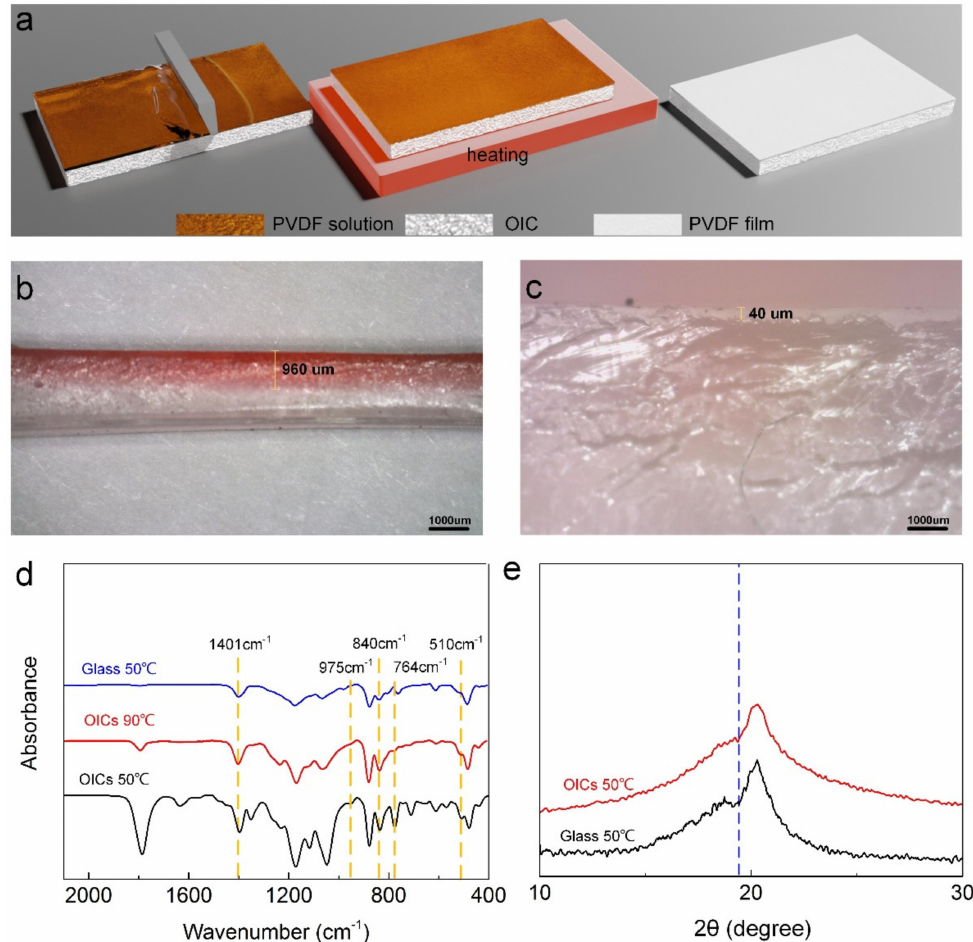
Figure 4. PVDF polarization detection. ( a ) Self-powered OIC preparation process, ( b ) penetration of DMF on OIC, and ( c ) the thickness of PVDF. ( d ) FTIR spectra of self-powered OICs on different substrates, and ( e ) XRD patterns of PVDF on glass and OICs after